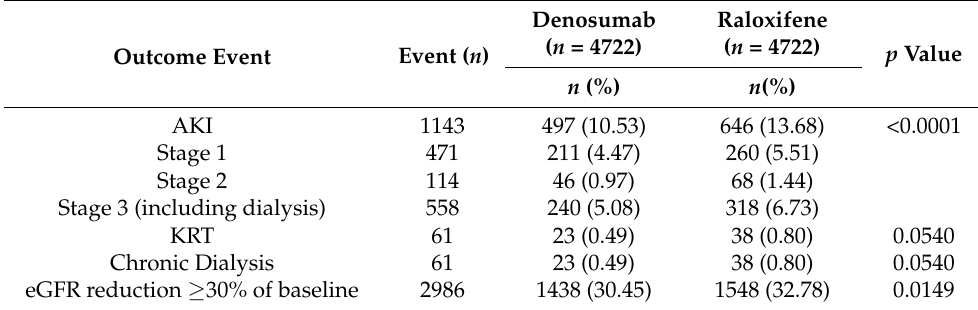
Table 2. Adverse kidney outcomes. AKI = acute kidney disease; Stage 1 = increase in serum creatinine by ≥ 0.3 mg/dL within 48 h, or increase in serum creatinine 1.5 to 1.9 times baseline that is known or presumed to have occurred within the prior 7 days; Stage 2 = increase in serum creatinine to 2.0 to 2.9 times baseline; Stage 3 = increase in serum creatinine to 3.0 × baseline, or increase in serum creatinine to ≥ 4.0 mg/dL or initiation of kidney replacement therapy; KRT = Kidney replacement therapy: chronic dialysis (no patients with kidney